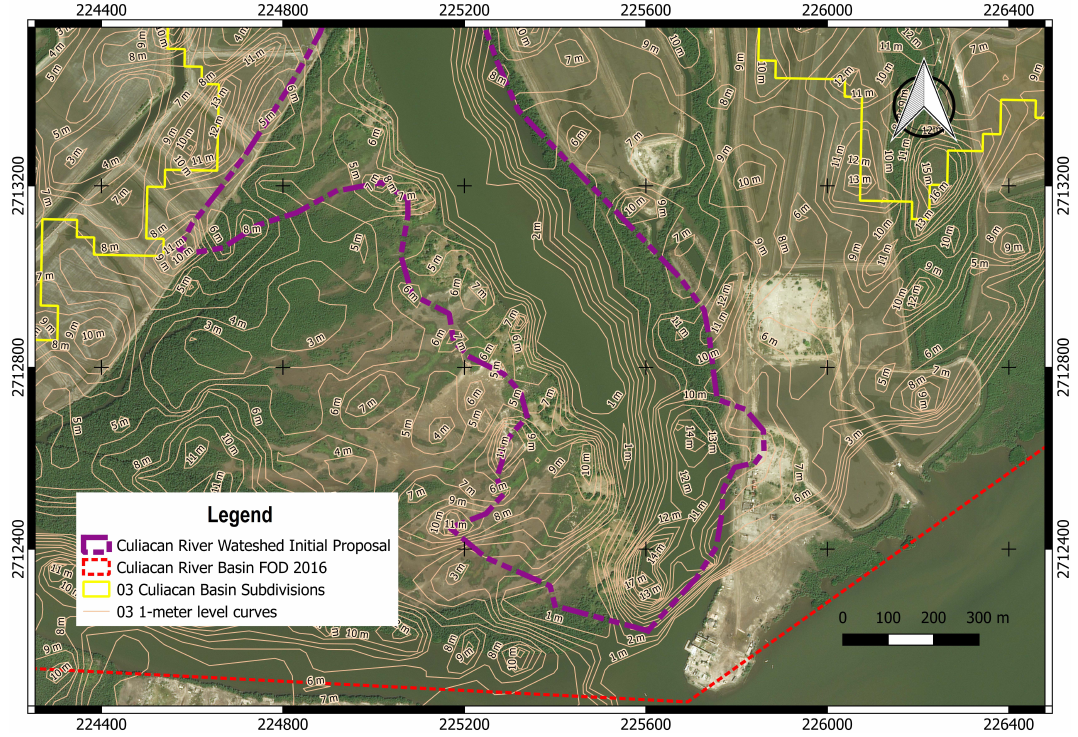
Figure 2. Use of level curves and watershed divides generated by GIS to propose an initial watershed divide.